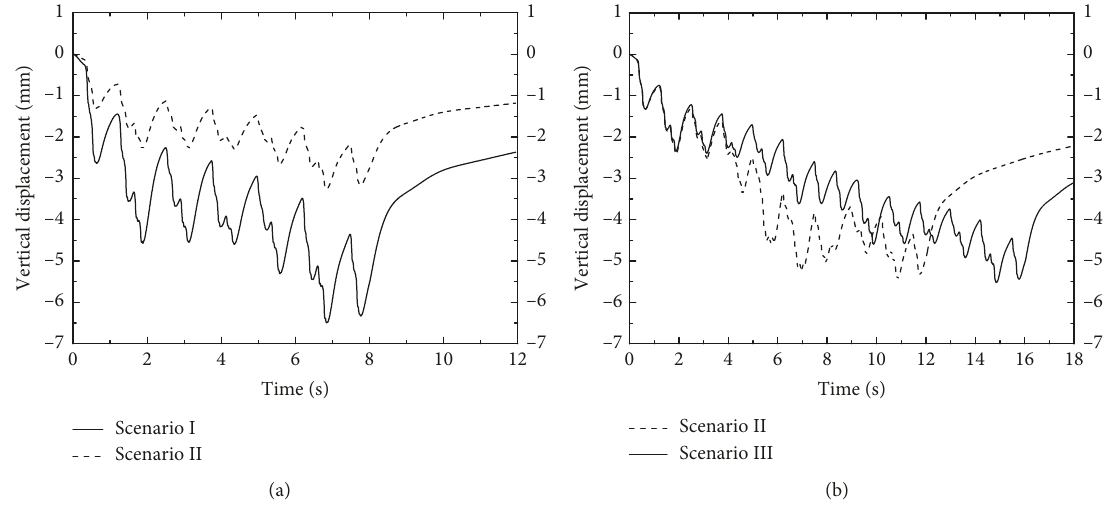
Figure 14: The displacement time-domain curve of A